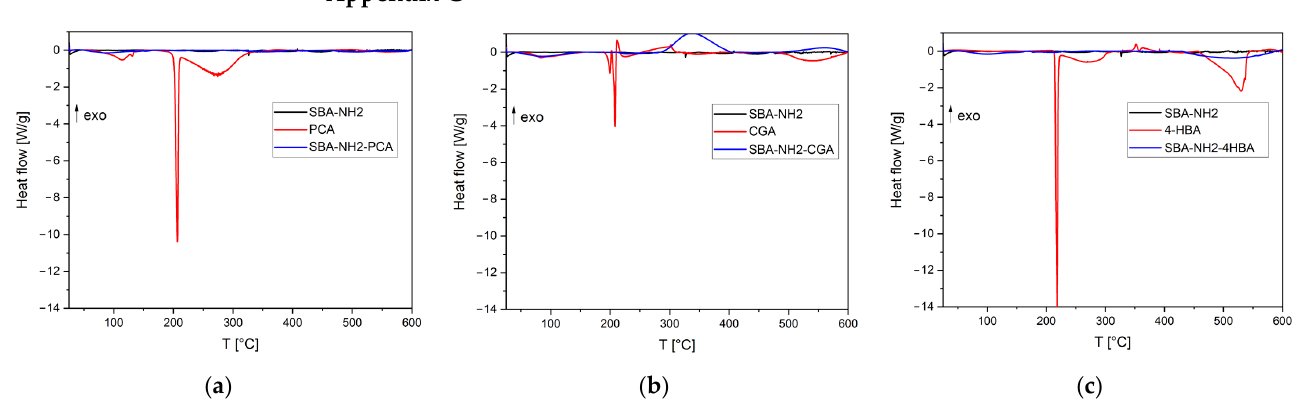
Figure A2. The FTIR spectra of parent SBA-NH2 and antioxidant-loaded SBA-NH2 silica materials (types of vibration: υ —stretching; δ —bending).